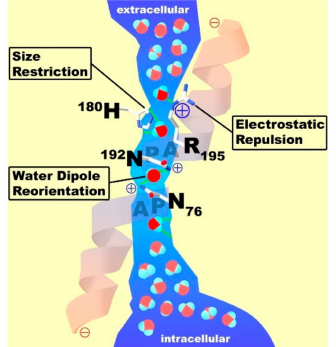
Figure 56. Schematic structure of the aquaporin channel. The fixed positive charge on the side chains of Arg-195 (R195) and His-180 (H180) create a barrier to cations, including the protonated water (H 3 O + ). The hydrogen bonds of the water chain adjacent to Arg-195 are broken, thereby preventing the formation of proton conductivity [150]. Reprinted with permission from [150]. Copyright 2002 American Society for Clinical